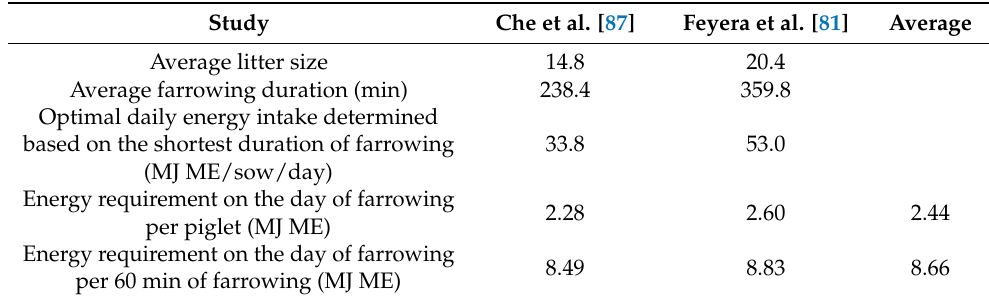
Table 1. Calculation on estimated energy requirements on the day of farrowing per piglet and per 60 min of farrowing based on Che et al. [87] and Feyera et al. [81]. Study Che et al. [87] Feyera et al. [81] Average Average litter size 14.8 20.4 Average farrowing duration (min) 238.4 359.8 Optimal daily energy intake determined 33.8 53.0 2.28